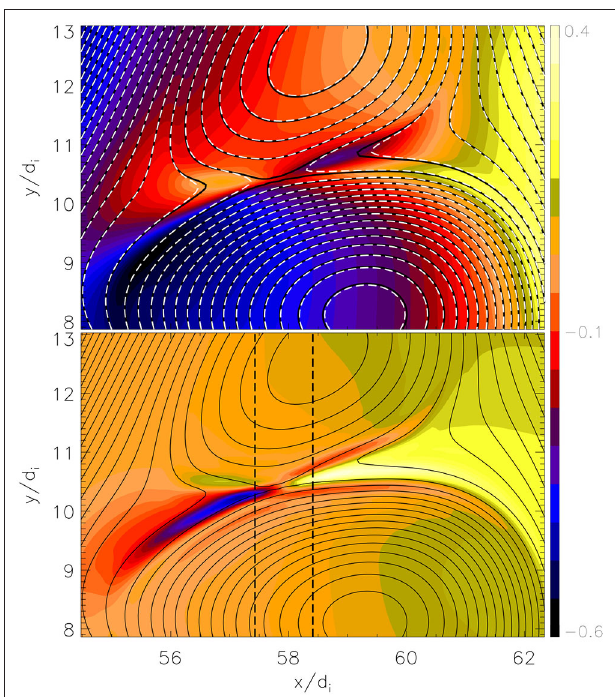
FIGURE 2 | From sim.A. Zoom-in on CS1 at t 42.5 (cid:127) − 1 i . (Top) Shaded = iso-contours of the out-of-plane magnetic field B z with superposed iso-contours of ψ (dashed white) and F (black). (Bottom) Shaded iso-contours of the x -component of the electron flow, u e, x , and of ψ (solid black lines). Dashed vertical lines trace the two virtual spacecraft trajectories shown in the two columns of Figure 3